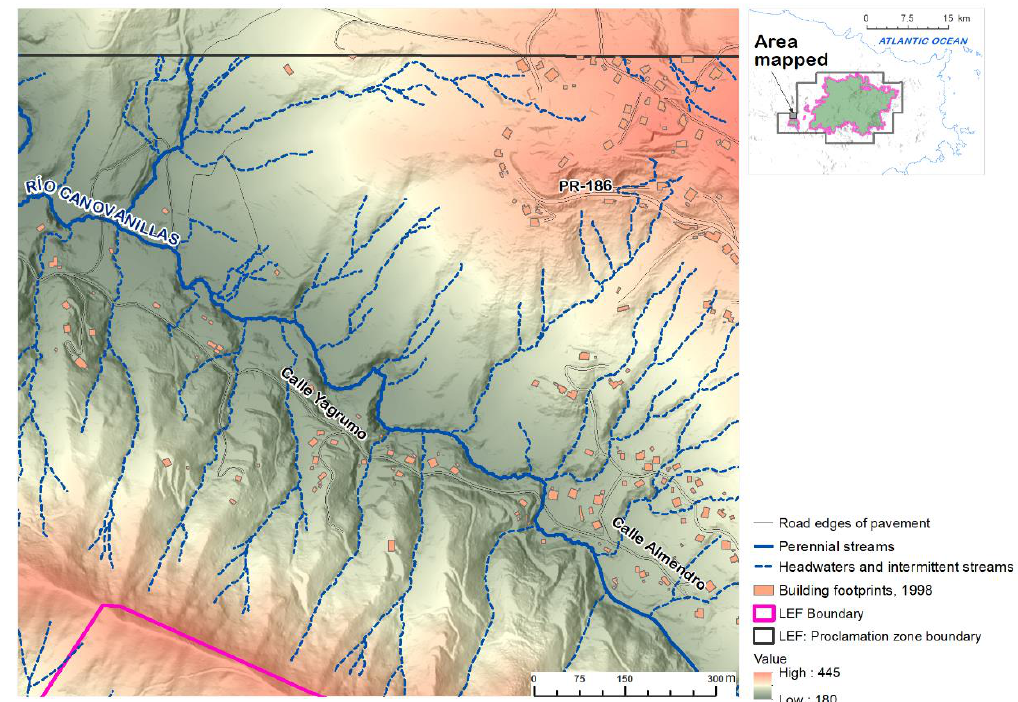
Figure 7. Example of headwaters, intermittent flow paths, and perennial channels derived from a threshold ≥ 5000 accumulated cells (0.5 ha).